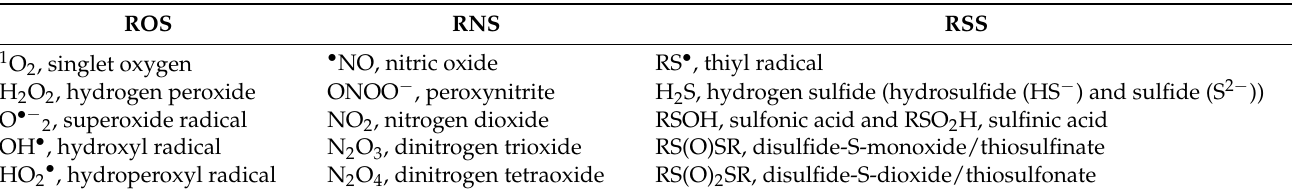
Table 1. List of major reactive oxygen species (ROS), reactive nitrogen species (RNS), and reactive sulfur species (RSS). Adapted from